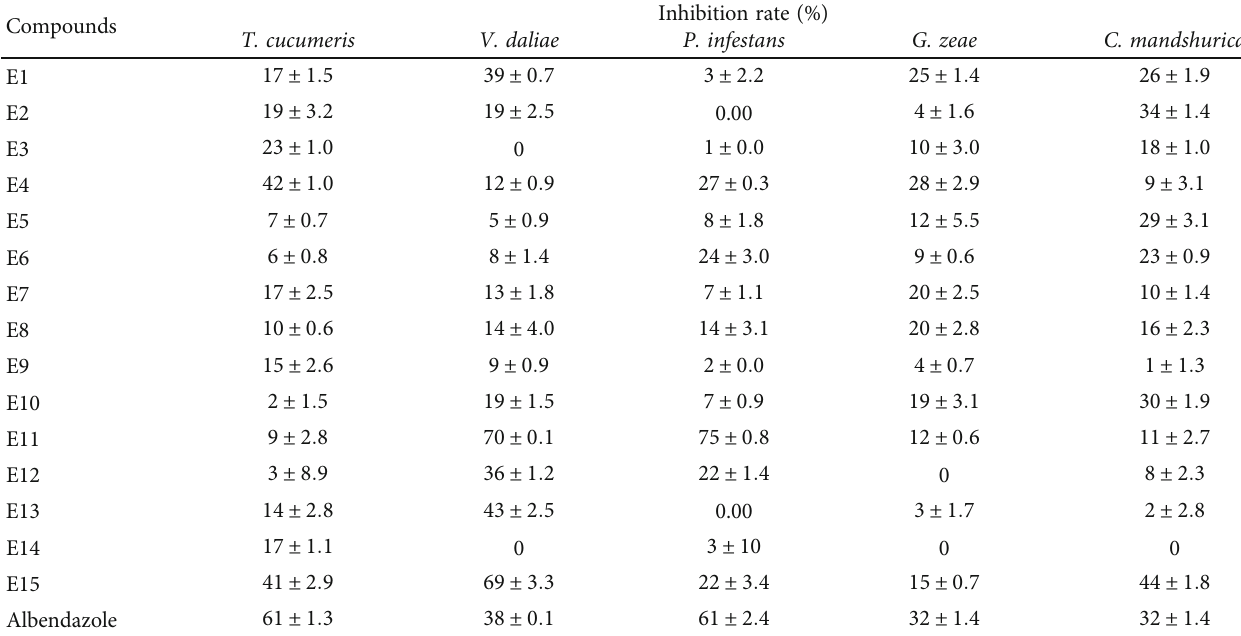
Table 3: The in vitro antifungal activity of the target compounds against C. mandshurica , T. cucumeris , B. cinerea , V. daliae , P. infestans , and G. zeae at 50 μ g/mL.